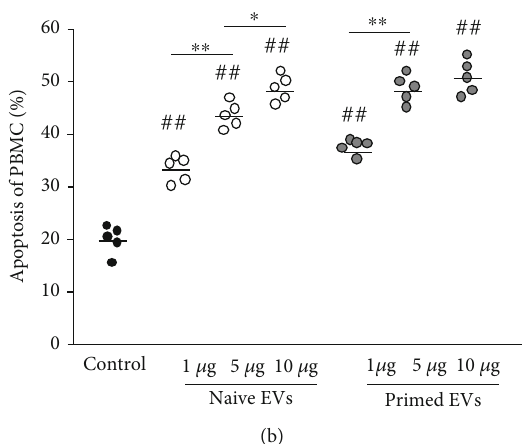
Figure 5: Apoptosis of PBMC cocultured with cADSC-EVs. (a) PBMCs stimulated with ConA were cultured in the presence of naive or primed cADSC-EVs at various concentrations (1, 5, and 10 μ g/ml) for 3 days. After culture, PBMCs were stained with Annexin V and PI and assayed by fl ow cytometry. (b) Comparison of apoptosis of PBMCs treated with various concentrations (1, 5, and 10 μ g/ml) of naive or primed cADSC-EVs. The induced ratio of PBMC apoptosis was not signi fi cantly di ff erent between naive and primed EVs at the same concentrations. The solid line indicates the average. ## P < 0 : 01 vs. PBMC stimulated with ConA. ∗ P < 0 : 05 , between groups. ∗∗ P < 0 : 01 , between groups.